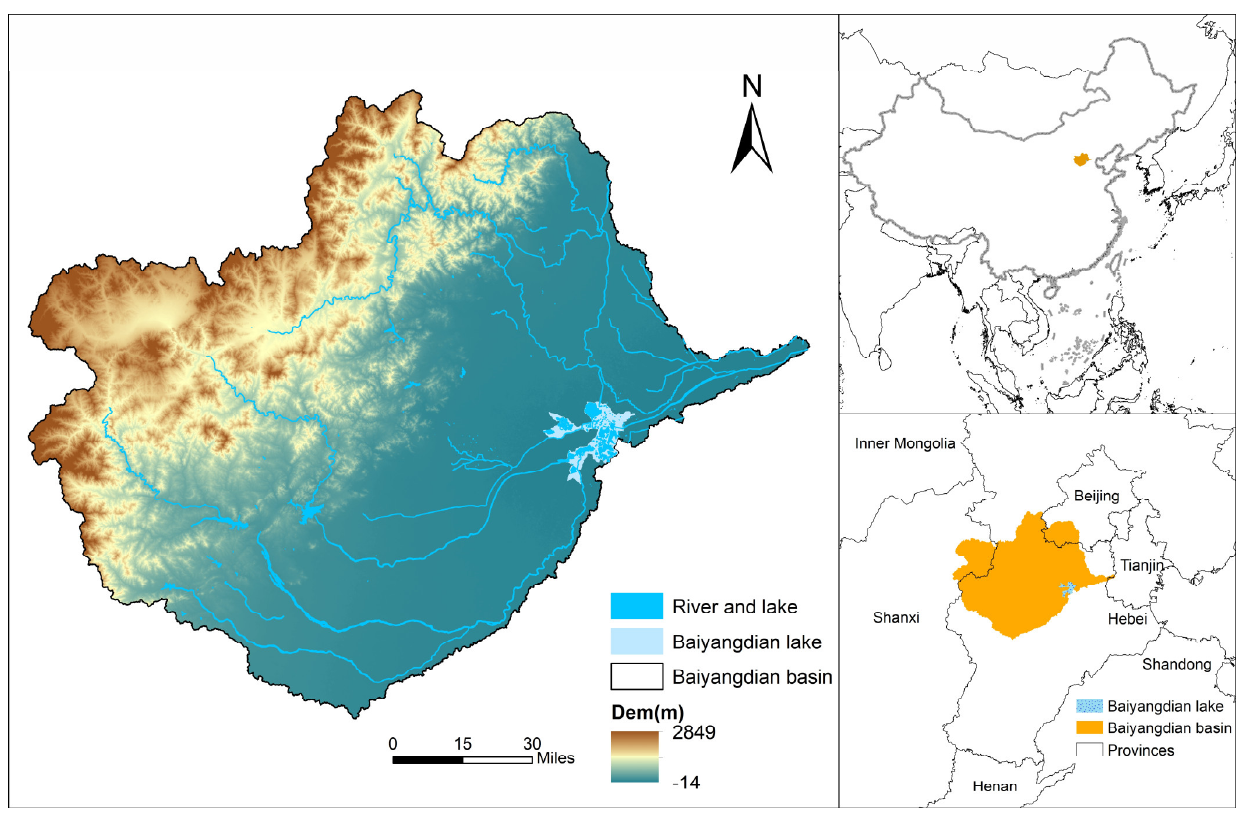
Figure 1. Location of the study area and its topographic